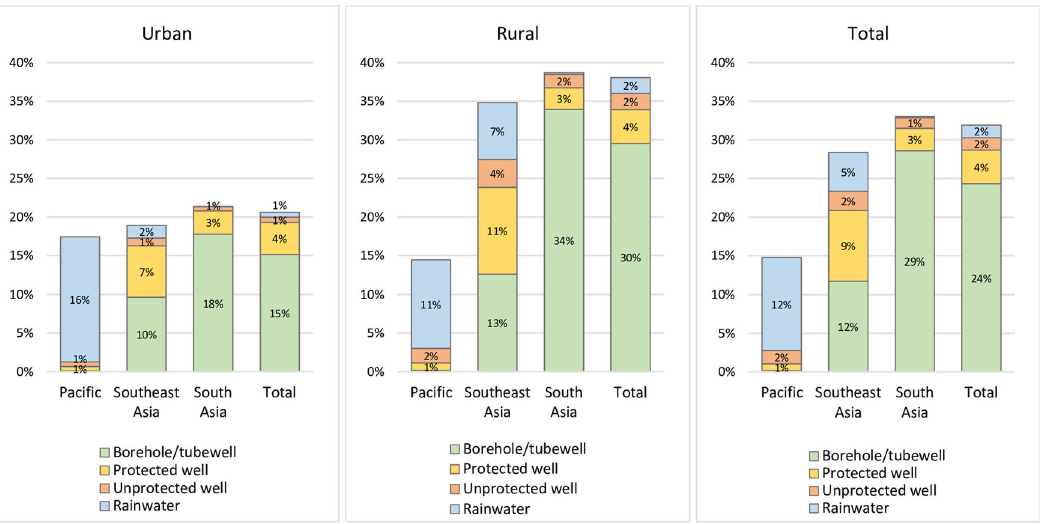
Fig. 5 Proportion of population using self-supply as a main drinking water source by source type and region. Boreholes/tubewells are the most common form of self-supply in Southeast Asia and South Asia, while rainwater collection is the dominant form of self-supply in the Paci fi